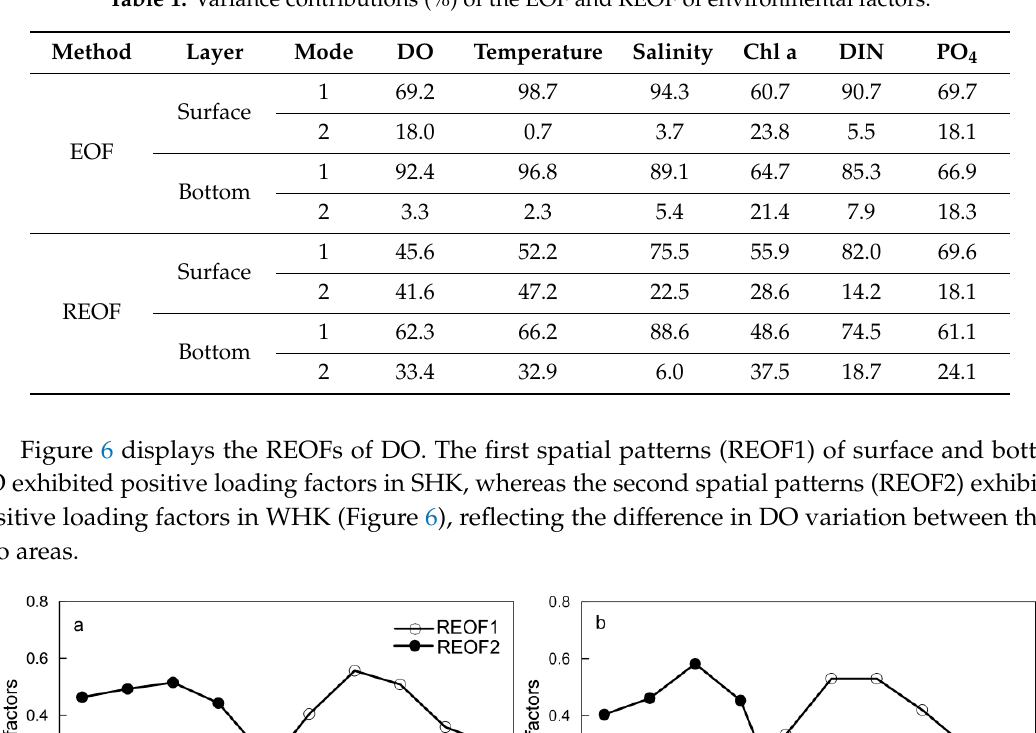
Table 2. Correlation coefficients between the REOFs of DO and those of other environmental factors.